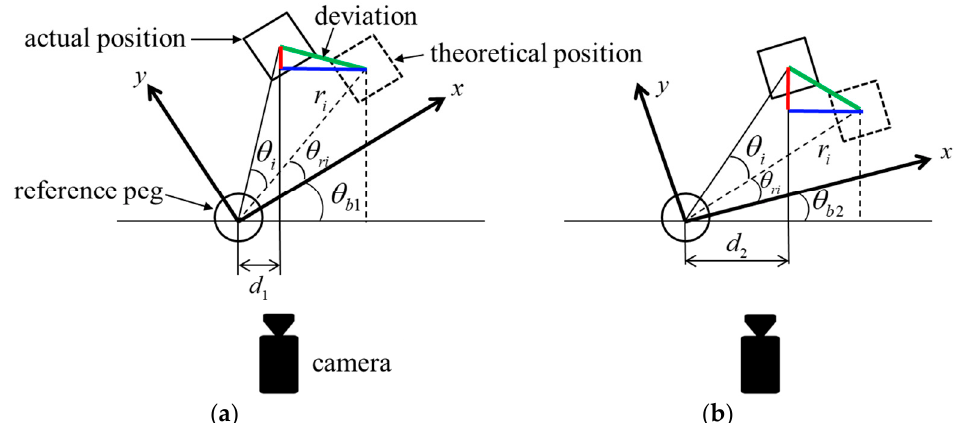
Figure 4. The bottom view of a connector. The solid square represents the pin of a connector at its actual position, and the dotted square represents the pin of a connector at its theoretical position. The solid circle represents the reference peg. ( a , b ) represent two different orientations θ b 1 and θ b 2 for the connector relative to the cameras.